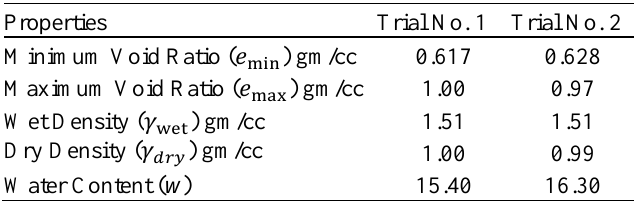
Results of relative density test Properties